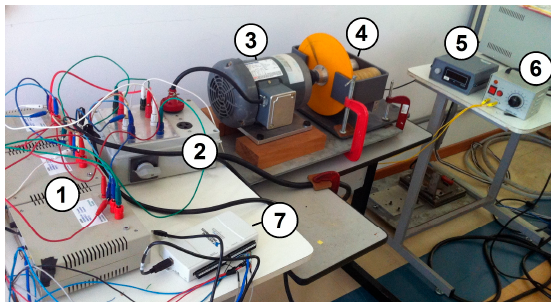
Figure 4. Photo of the laboratory setup for experimental tests.